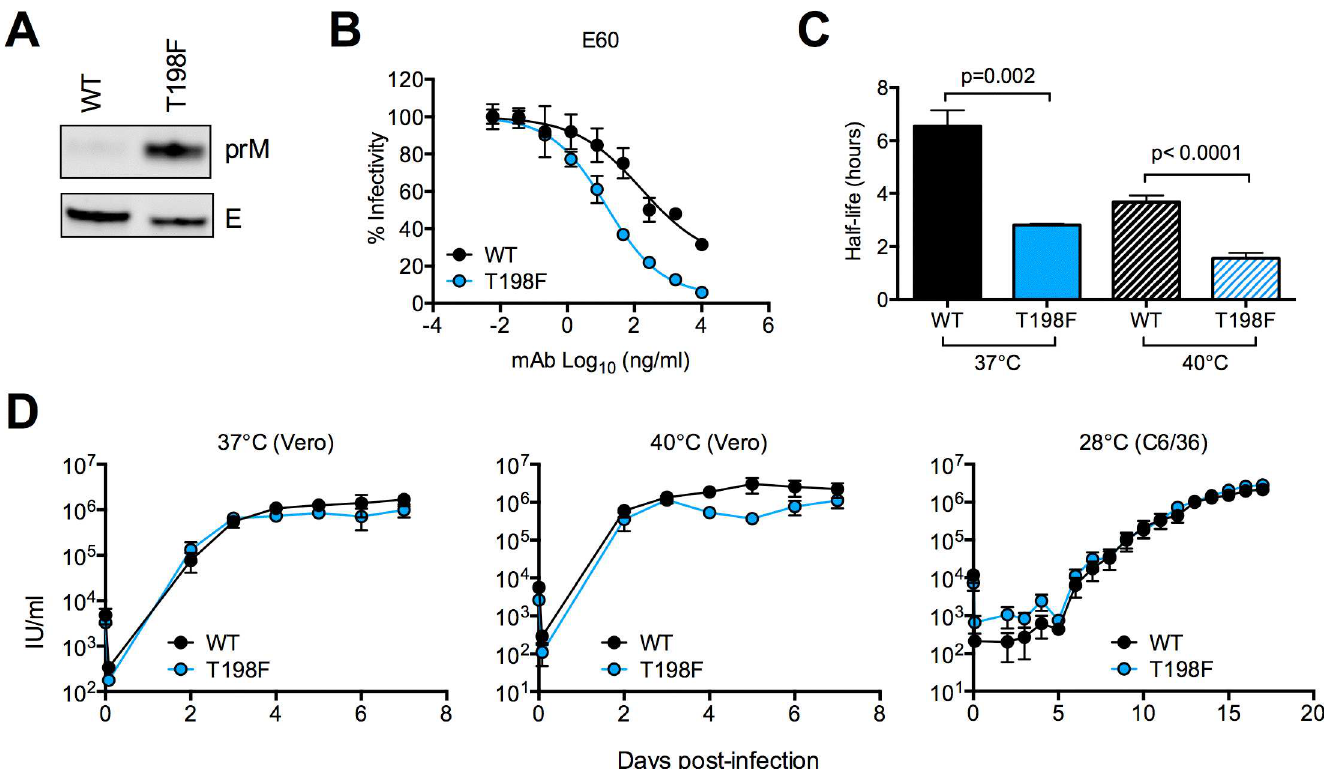
Fig 7. Characteristics of WNV E T198F fully infectious viruses. (A) The efficiency of prM cleavageof standard preparations of WT or T198F viruses was assessed by SDS-PAGE followedby Western blottingof pelletedvirions, as describedin Fig 2 . (B) Sensitivity of standard preparations of WT and T198F WNV-GFP to neutralization by mAb E60. The y- and x-axes indicatepercent infectivity and mAb concentration, respectively. Percent infectivity was normalizedto levels obtainedin the absence of antibody. Neutralization curves shownare representative of two independent experiments performed in duplicateusing independentvirus preparations. Error bars indicate the range of infectivity. (C) Paired t-tests were used to comparethe half-life of infectivity of standard preparations of WT and T198F viruses followingprolongedincubationat 37˚C or 40˚C as describedin Fig 4 . Shownare the mean half-life values obtained from three independentexperiments performed in triplicate using independentvirus preparations. Error bars indicatethe SEM. (D) Standardpreparations of WT and T198F viruses were used to infect Vero cells at 37˚C or 40˚C and C6/36 cells at 28˚C at a MOI of 0.05. At the indicated time points, virus supernatant was collectedand used to infect Raji-DC-SIGN-R cells to determine viral titers. Growth curves shown are based on average titers obtainedfrom three independentexperiments performed in duplicateusing independentvirus stocks. The y- and x-axes indicatevirus infectiousunits (IU) per ml and days post-infection,